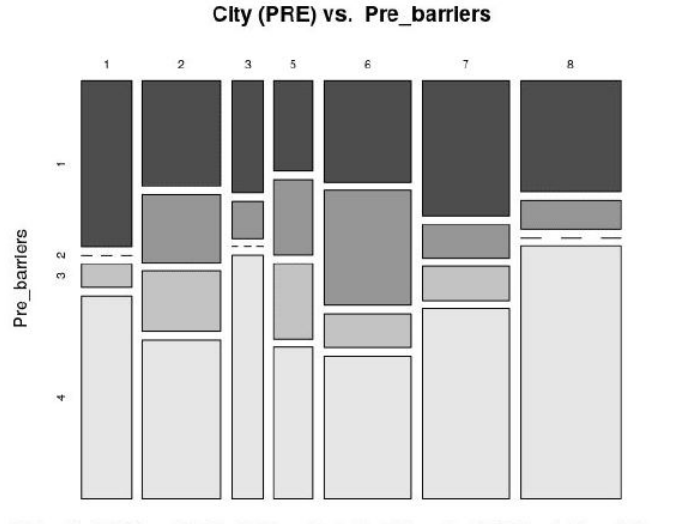
Figure 7. PRE-pilot: Comparison of the distribution to barriers encountered in each pilot: Absentmindedness (1), Lack of Awareness (2), Discouragement from Peers (3) and Other Reasons (4). In a glimpse we can observe that there are differences among certain